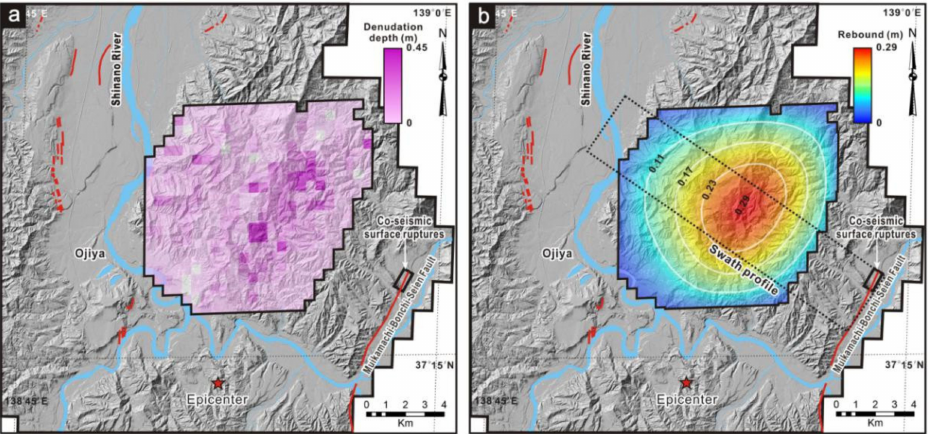
Figure 8. The denudation depth distribution in 500-m pixels ( a ), and the predicted isostatic response to the landslide removal ( b ). The denudation depth is obtained by averaging the total volume in a pixel by the pixel’s area. The predicted isostatic response is calculated based on the 500-m pixel averaged denudation depth